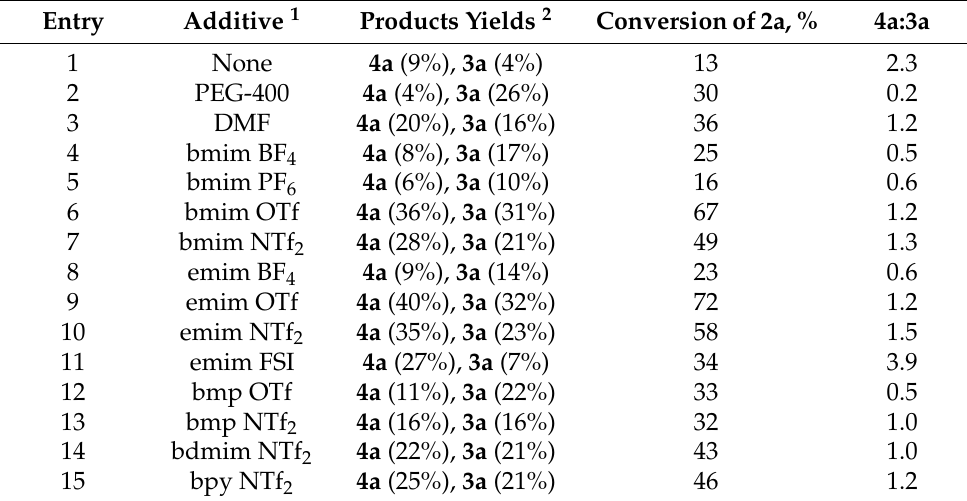
Table 1. The influence of grinding additives on the rate and selectivity of fluorination of 2-naphthol with F-TEDA-BF 4 .